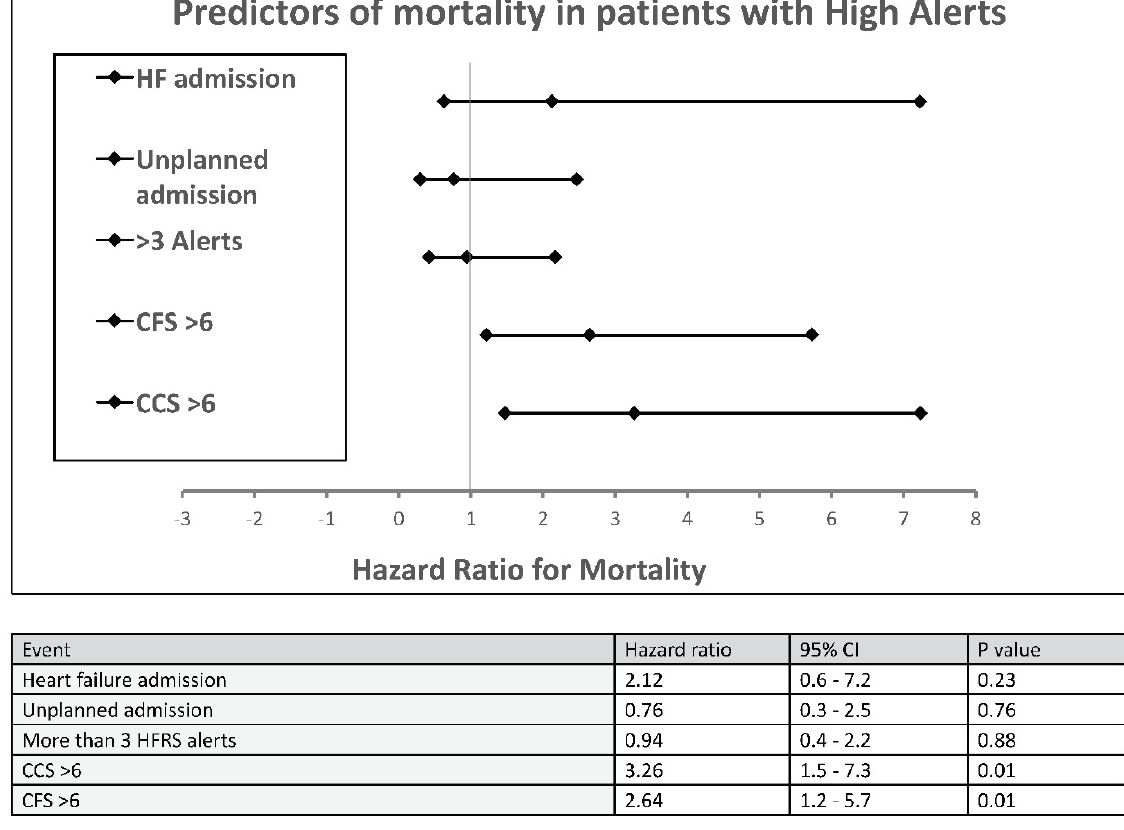
Figure 3. Predictors of mortality in patients with high-risk alerts. HF: Heart Failure, HFRS: Heart failure risk score, CCS: Charlson Comorbidity Score, CFS: Clinical Frailty Score (Rockwood).